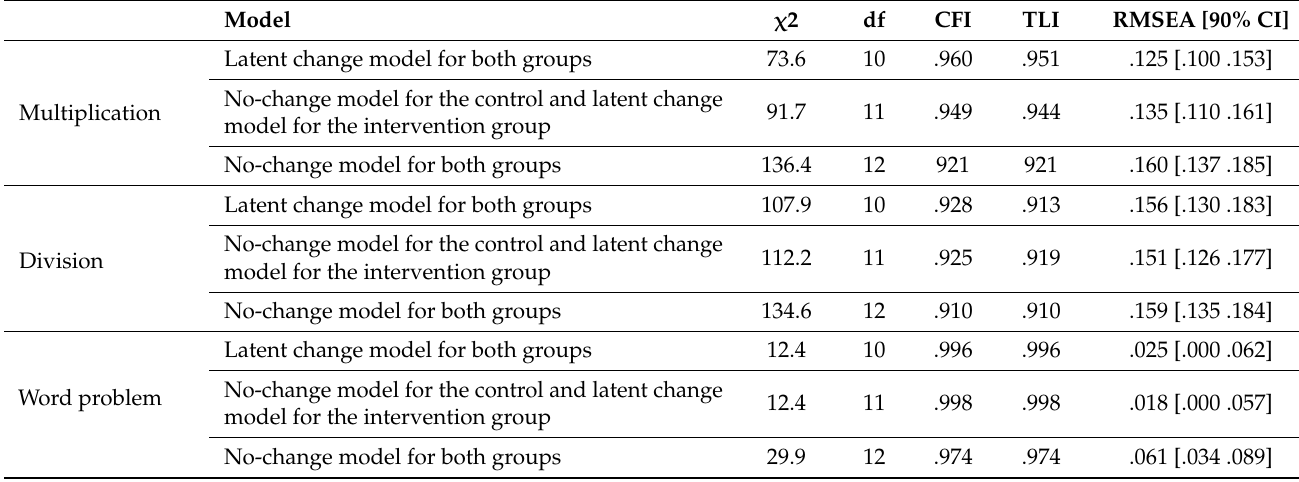
Table 9. Goodness-of-fit indices for the tested models on sub-test